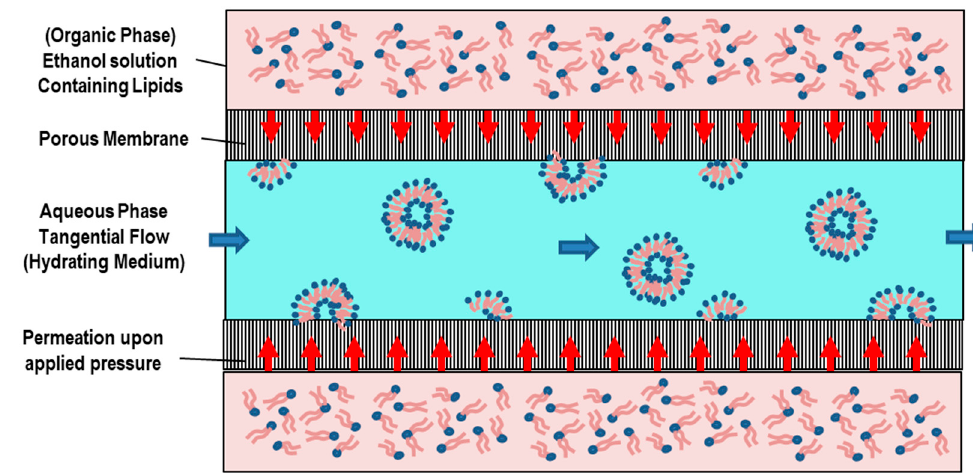
Figure 16. Liposome formation process in the membrane contactor method.